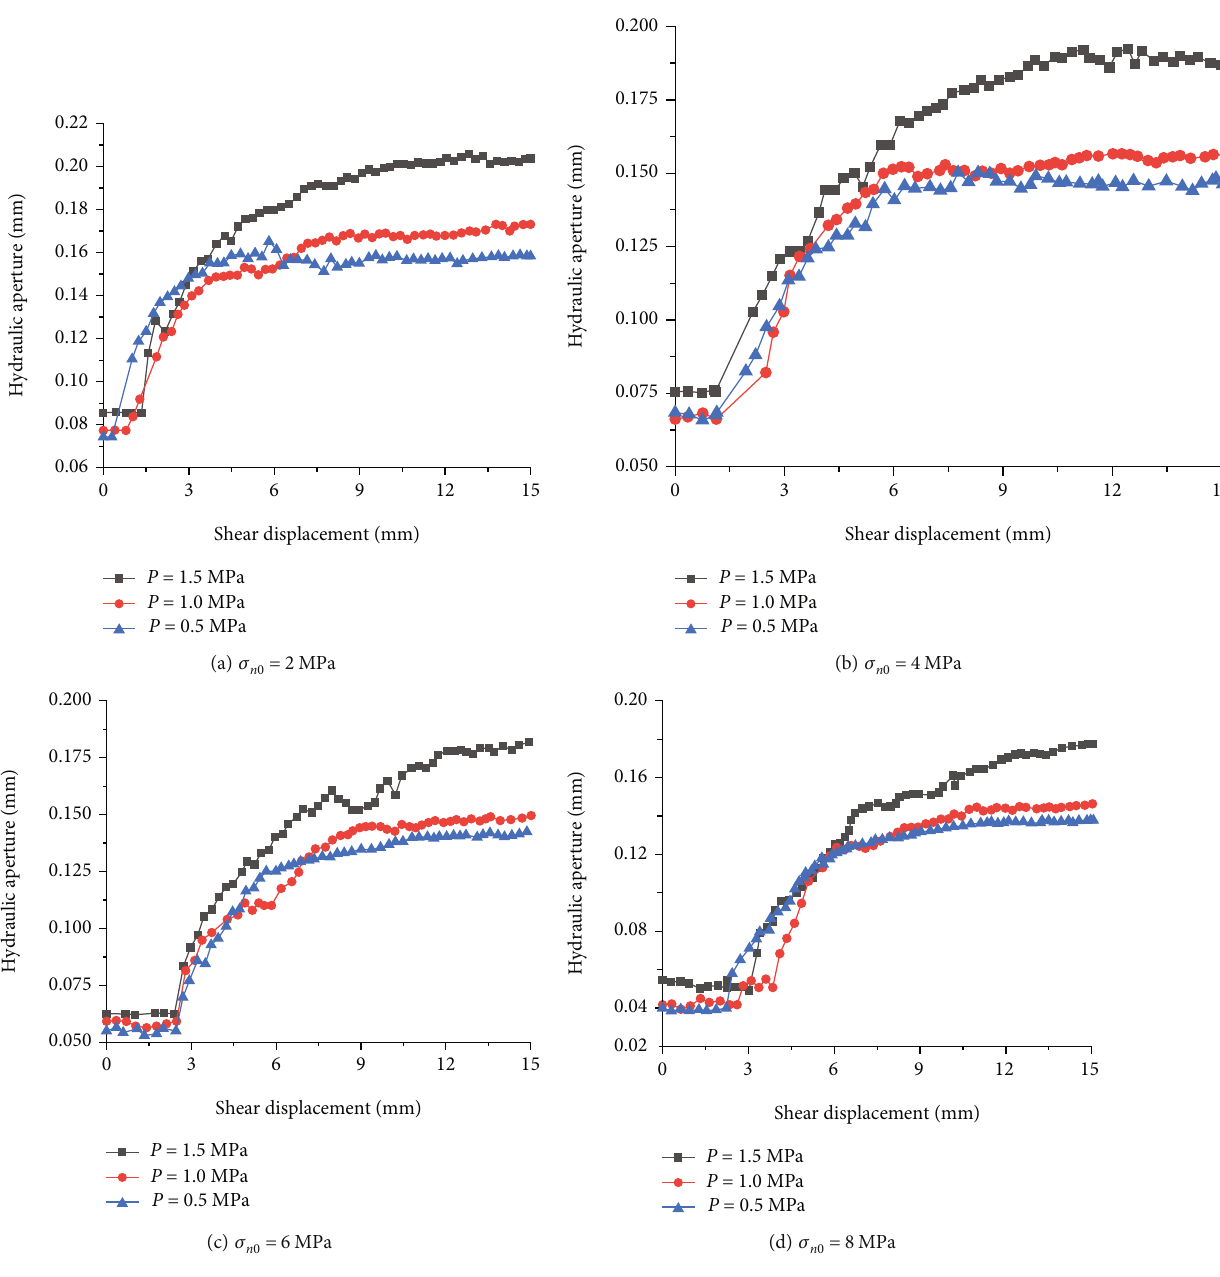
Figure 15: Curves of hydraulic aperture with shear